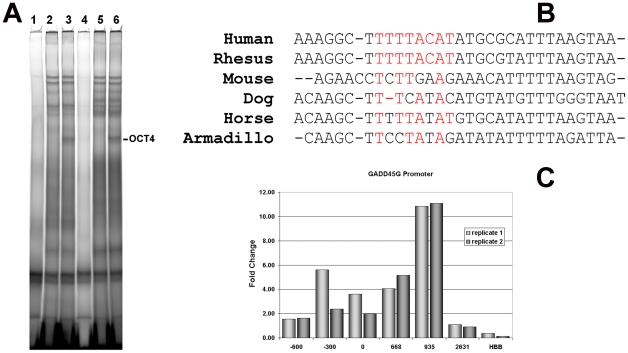
The GADD45G promoter harbours the evolutionary conserved OCT4 binding sites.A: Bandshifts showing supershifts with OCT4 antibody using NCCIT cells derived- nuclear extracts using two probes in the 5′region of the GADD45G promoter containing an OCT4 motif at positions 9–15 (lane 1–3) and 17–23 (lane 4–6) of 31 nucleotides. Lane 3,6: Nuclear extract plus labelled probe. Lane 2,5: same as lanes 3 and 6 but with the addition of OCT4 antibody (sc-9081). Lane 1,4: same as lanes 3 and 6 but with the addition of a 20-fold increase in unlabelled competitor oligo. B: Multi-species alignment of the selected region chosen for the bandshift assay, the conserved OCT4 binding site is highlighted in red. C: Real time PCR confirmation of the presence of the OCT4 binding site. Position 0 indicates the position shown in the alignment in panel 2B.